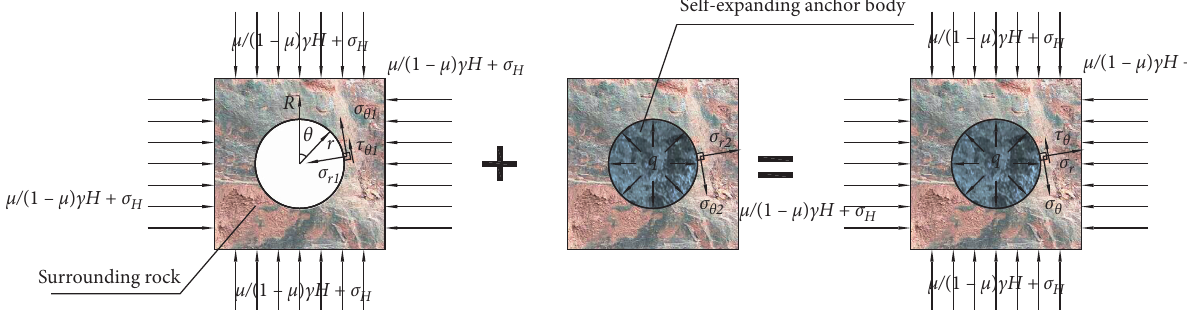
Figure 15: Superposition principle of stress distribution of the surrounding rock under the self-expanding anchor